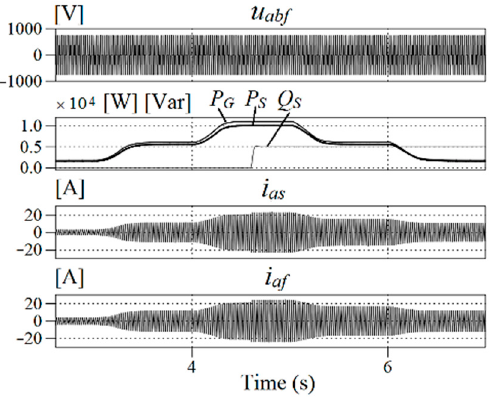
Figure 18. Waveforms of the generator’s phase-to-phase voltage u abf , power output P G , power supplied to the grid P S , reactive power Q S , grid current i as , and inverter current i af.